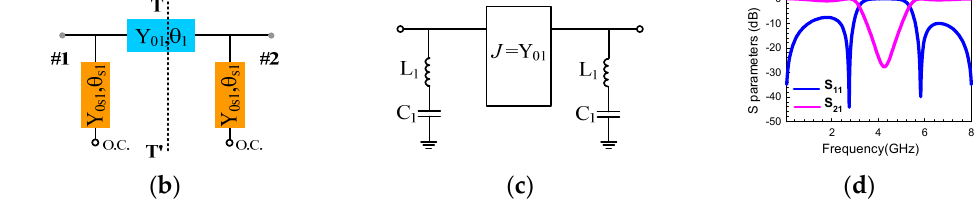
Figure 1. ( a ) A bandstop filter circuit with open-circuit stubs ( b ) TL model ( c ) LE model ( d ) frequency response.